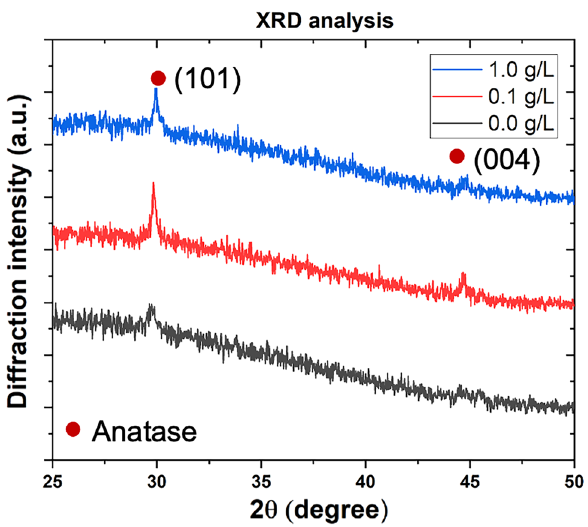
Figure 5. XRD diffractograms of TiO 2 /SiO 2 -np nanocomposite films synthesized from different concentrations of SiO